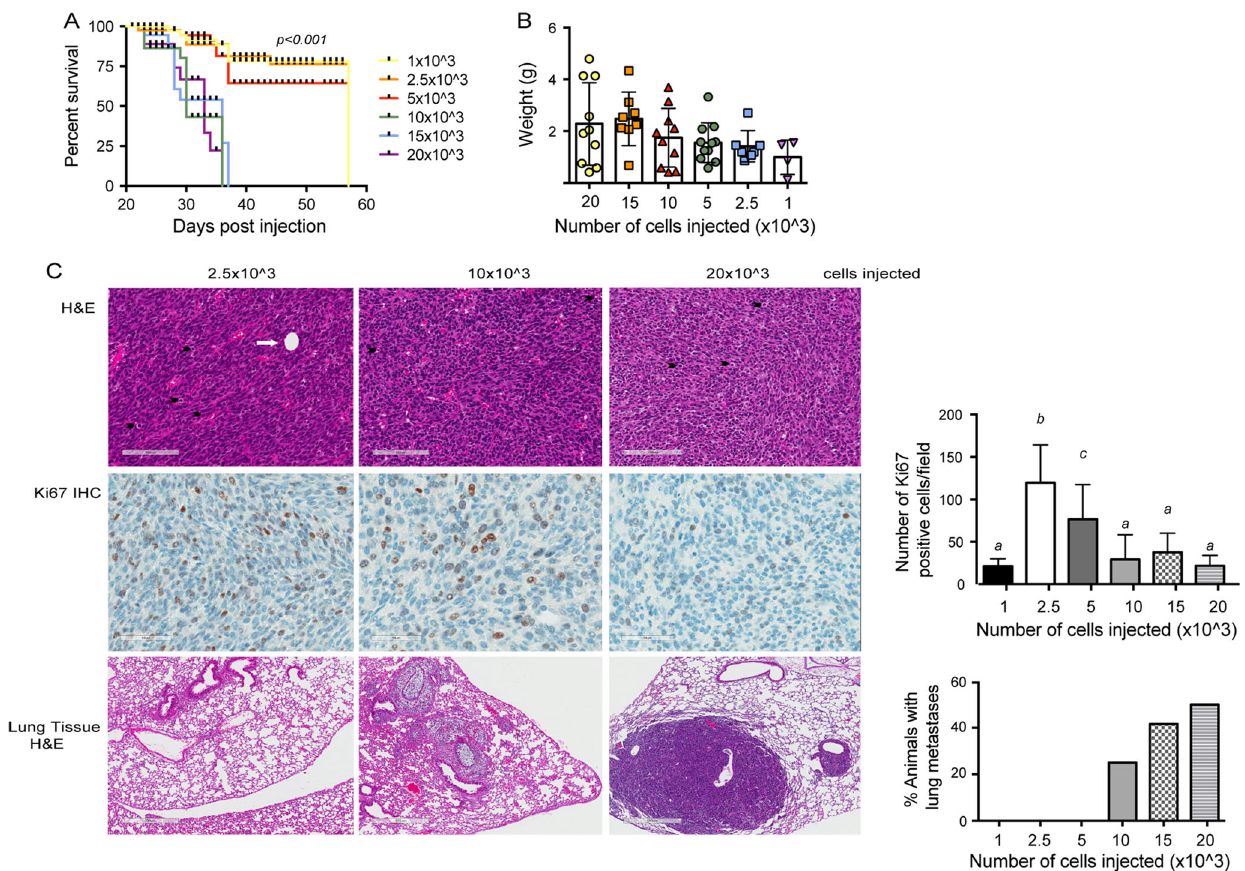
Fig. 2 Tumorigenicity and metastatic potential of metM-Wnt lung cells. a Survival curve (time until tumor reached 1.5 cm in any direction) of C57BL/6 mice transplanted with increasing concentrations of metM-Wnt lung cells into the fourth mammary fat pad (1 × 10 3 , 2.5 × 10 3 , 5 × 10 3 , 10 × 10 3 15 × 10 3 , or 20 × 10 3 cells per mouse; n = 12/group). b Resultant tumor weights of cells transplanted in ( a) . c Representative micrographs of metM-Wnt lung mammary tumors stained with H&E (top panel, scale bar 100 μ m) and proliferative marker Ki67 (middle panel, 50 μ m), and lung tissue stained with H&E (bottom panel 500 μ m) from mice transplanted with the number of cells indicated. Bar graphs show the average number of proliferative cells per fi eld (six fi elds chosen at random, n = 6 tumors) and incidence of metastatic lung tumors, mean ± SD. White arrow indicates intratumoral adipocyte, black arrows indicate apoptotic